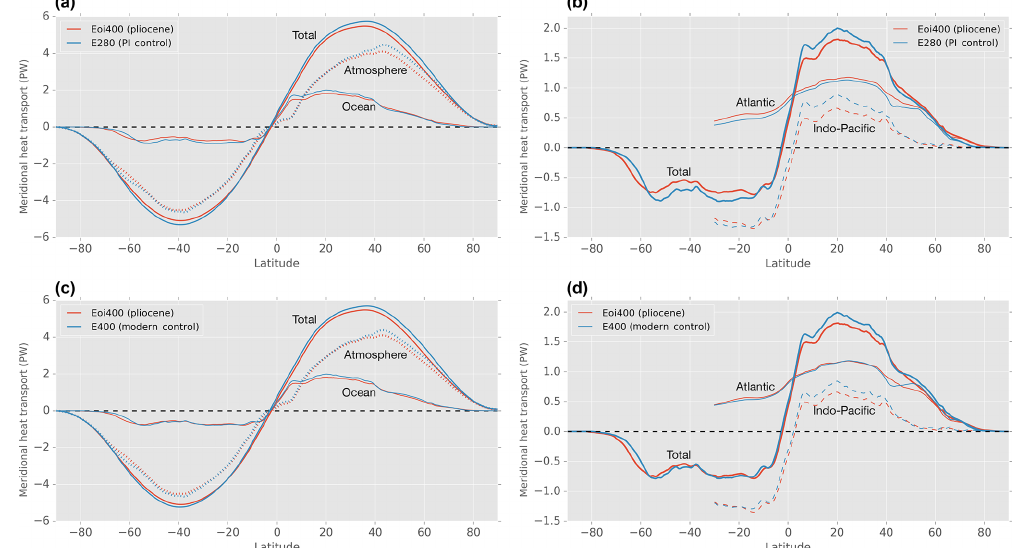
Figure 15. Total meridional heat transport and its decomposition. The top (bottom) row compares the E oi 400 P mid-Pliocene simulation (cid:104) 2691 , 2720 (cid:105) to the PI E 280 P (cid:104) 5131 , 5160 (cid:105) (modern E 400 P (cid:104) 1931 , 1960 (cid:105) ) control. The left column shows the total meridional heat transport and its decomposition into the atmospheric and oceanic components. The right column decomposes the oceanic components into the transport in the Atlantic and the Indo-Pacific basins. The (cid:104)(cid:105) denotes the range of model years over which the climatology was